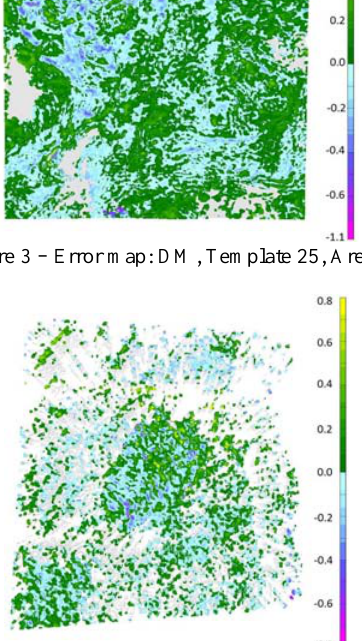
Figure 4 – Error map: DM, Template 25, Area02